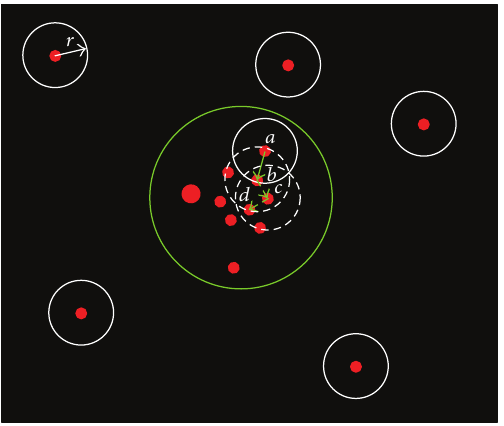
Figure 4: Blob clustering process.